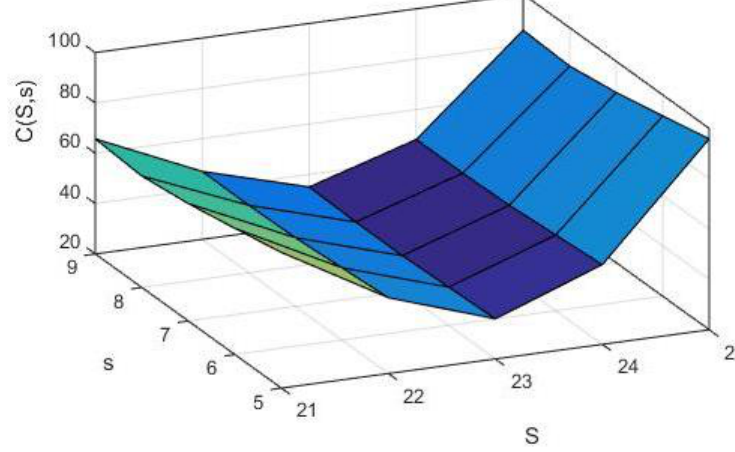
Figure 1. Convexity of the total cost with two variables S and